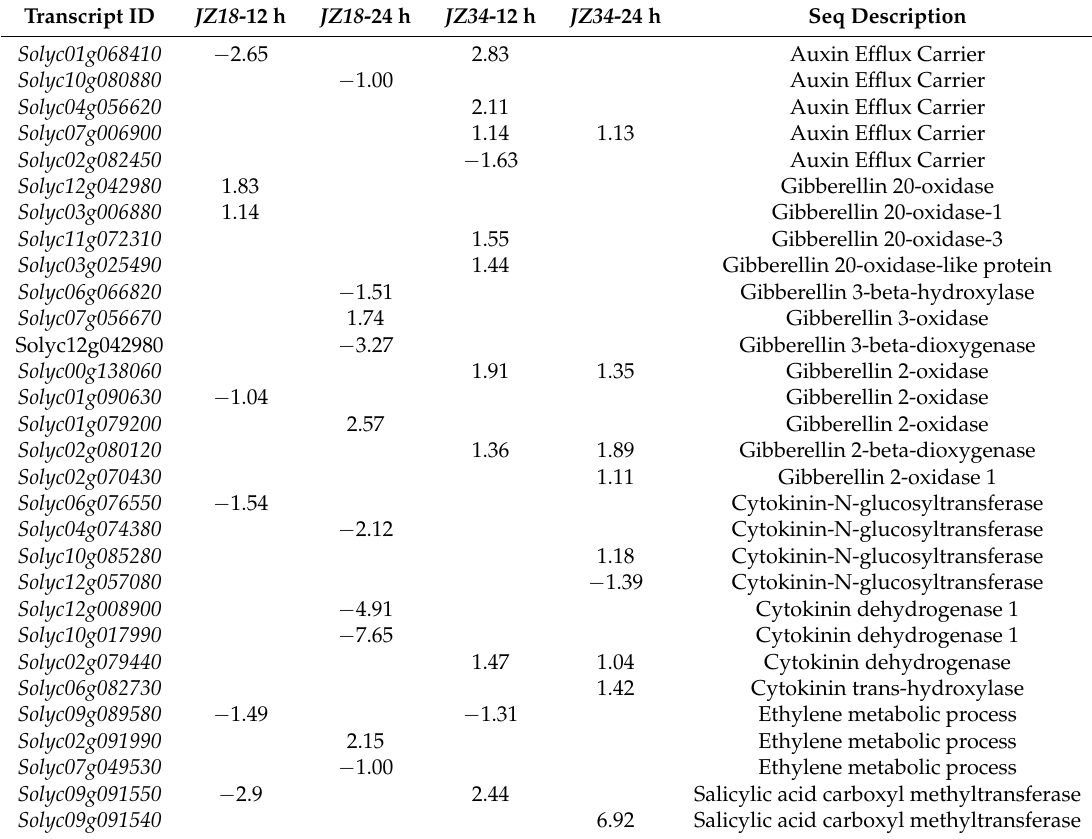
Table 6. Folds change of DEGs related to hormone signaling in response to K + -deficiency (0.5 mM)